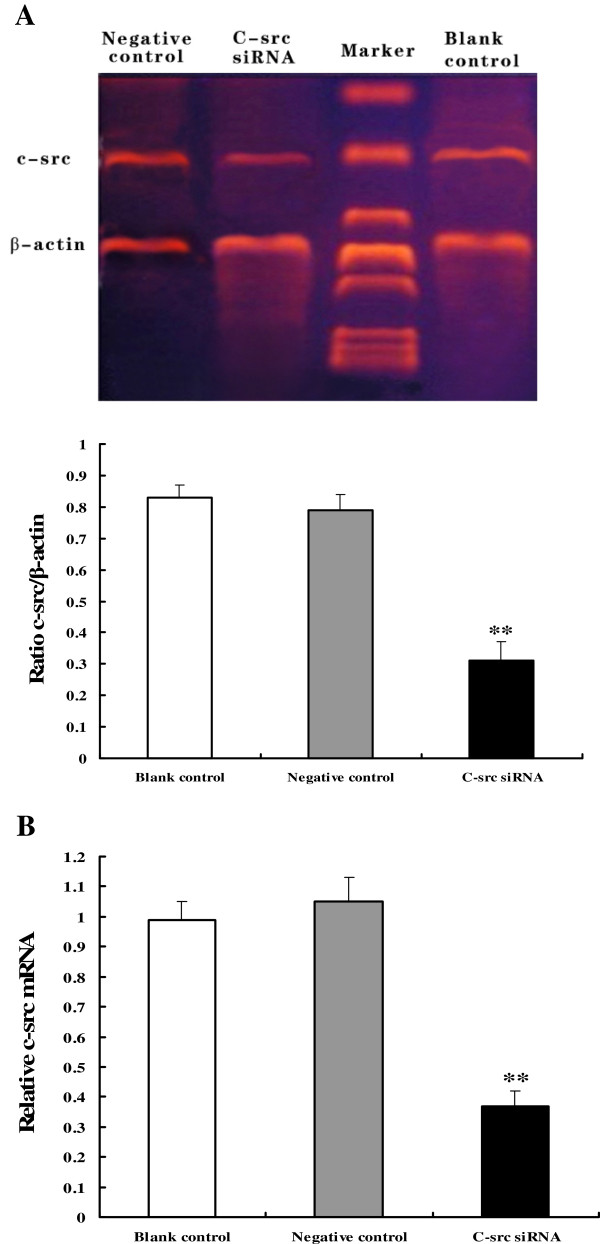
The silencing efficiency of the lentivirus after transfection.A, c-src mRNA in ovaries 8 days after lentivirus transfection and a semiquantitative assay of the c-src mRNA levels 8 days after lentiviral transfection from six different replicates. B, Real-time PCR was used to analyze the relative c-src mRNA (c-src mRNA/β-actin mRNA). Blank control corresponds to the group that was transfected with c-src-non-targeting oligonucleotides, negative control corresponds to the group that was transfected with a blank vector (lentivirus without siRNA), and c-src siRNA corresponds to the group with the lentivirus packaging c-src siRNA. The data are presented as the means ± SEM (n = 3). **P<0.01 compared with the negative control group.